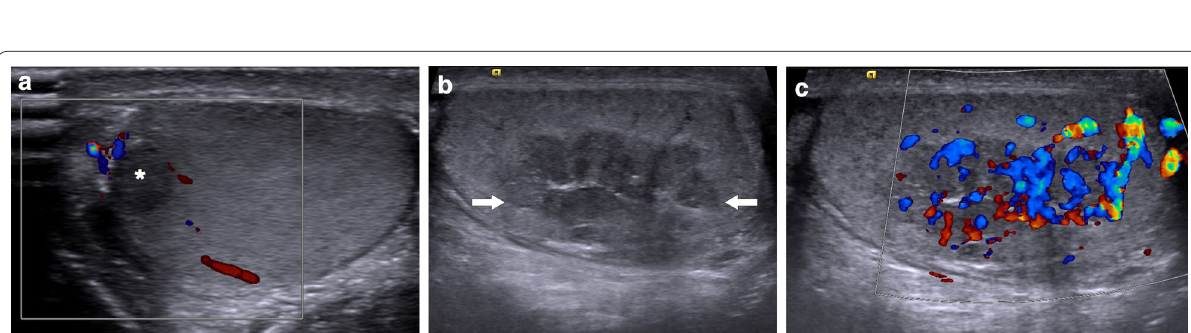
Fig. 18 Two different patients with known history of congenital adrenal hyperplasia. a Gray scale and color Doppler US images show round lesions in both testes in 13-year old male. The most prominent lesion appears as a focal hypoechoic lesion within the mediastinum of the right testis (asterisk). There was no significant internal vascularity on color Doppler US. Based on the patient’s history and imaging findings, testicular adrenal rests was considered. Serial US exams over 2-years confirmed stability of testicular lesions. b‑c Gray scale US b shows bilateral lobulated, large-sized hypoechoic lesions within the mediastinum testis in 15 years-old male. The largest lesion was detected within the right testis as a predominantly hypoechoic, heterogenous lesion (arrows). c On color Doppler US, there was intense internal vascularity within the lesion. These lesions were also considered to be consistent with testicular adrenal